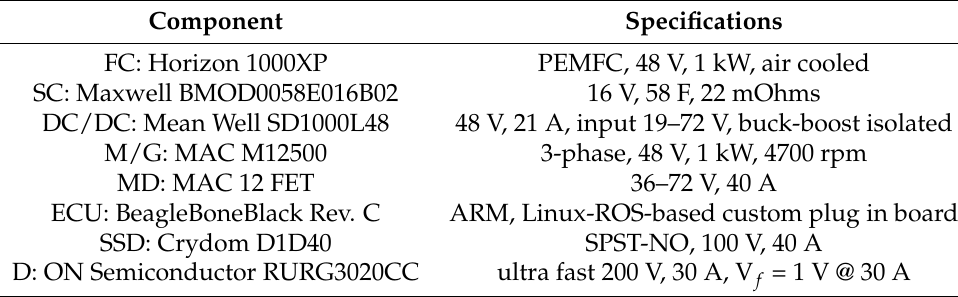
Table A1. Specifications of the electrical system’s off-the-shelf components.